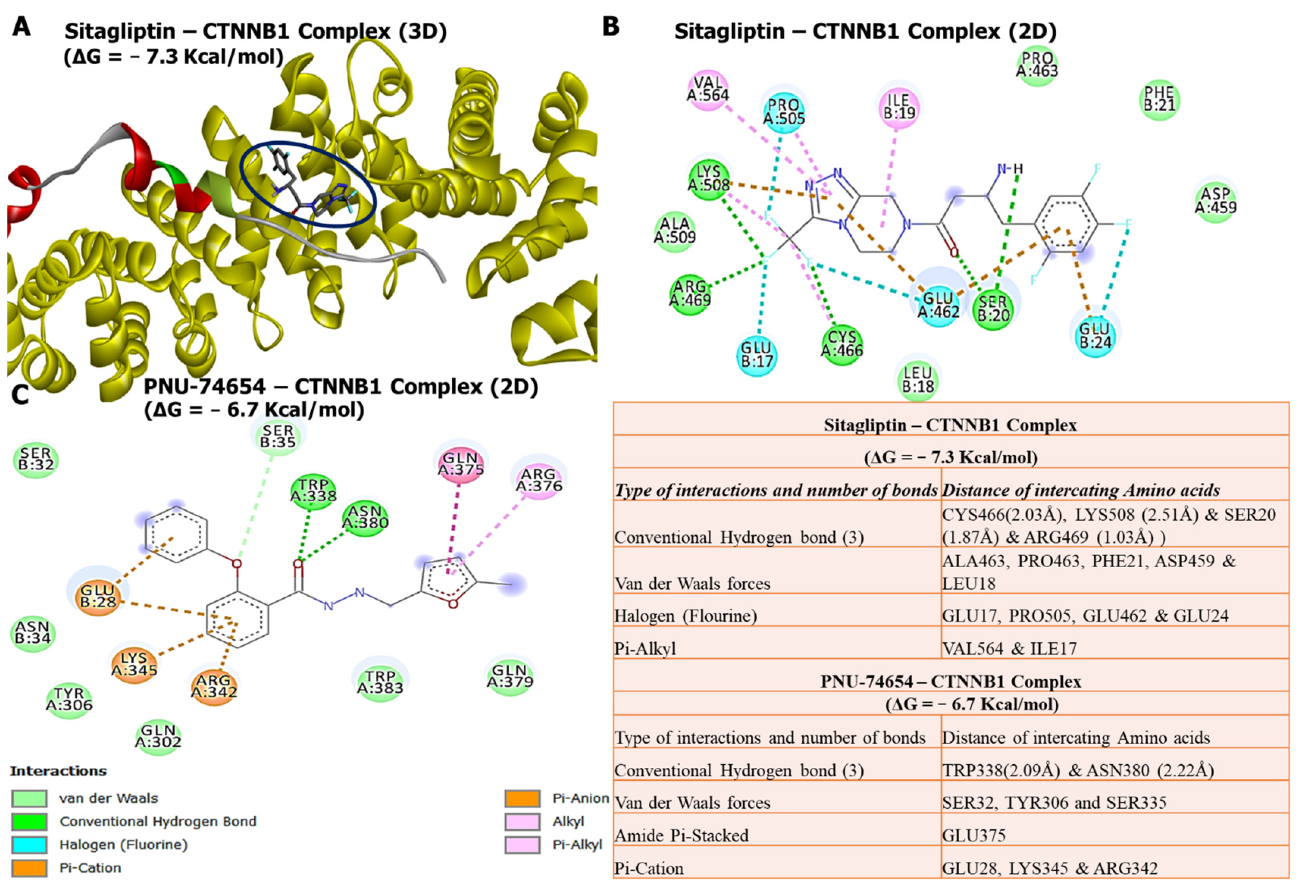
Figure 7. In silico molecular docking analysis of ligand–protein interactions. ( A ) Three-dimensional (3D) representation of sitagliptin in complex with CTNNB1 with a binding energy of − 7.3 kcal/mol. ( B ) Two-dimensional (2D) representation of sitagliptin in complex with CTNNB1 , showing interactions with four conventional H-bonds and shorter binding distances, with interactions further stabilized by different amino acids around the sitagliptin backbone. ( C ) Two-dimensional (2D) representation of PNU-74654 in complex with CTNNB1 , displaying lower binding energy of − 6.7 kcal/mol, and interactions with (2) conventional hydrogen bonds with longer binding distances compared with that of sitagliptin, in the binding pockets of CTNNB1 . The accompanying table shows a summary of the results.